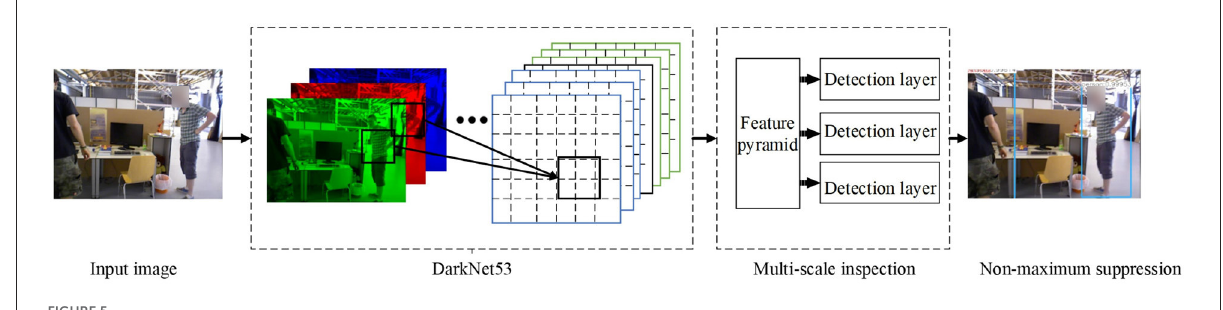
FIGURE5 YOLOv3 detection process.